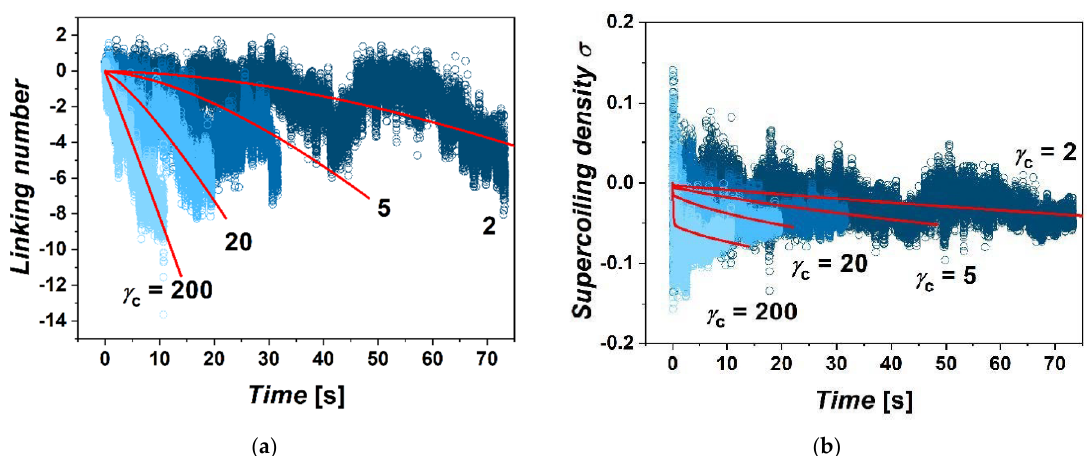
Figure 2. The simulations of supercoiling. ( a ) The graphs show accumulations of linking numbers in terms of White’s formula ∆ Lk = ∆ Tw + ∆ Wr . The accumulation of the linking number is shown as dependence of time for four settings of friction between cohesin ring and chromatin fiber γ c = 2, 5, 20 and 200. ( b ) Density of supercoiling obtained as σ = ∆ Lk / ℓ . The red lines are the fits obtained from solving the differential system of equations describing the accumulation of supercoiling with a moving permeable boundary defined by the position of cohesin.